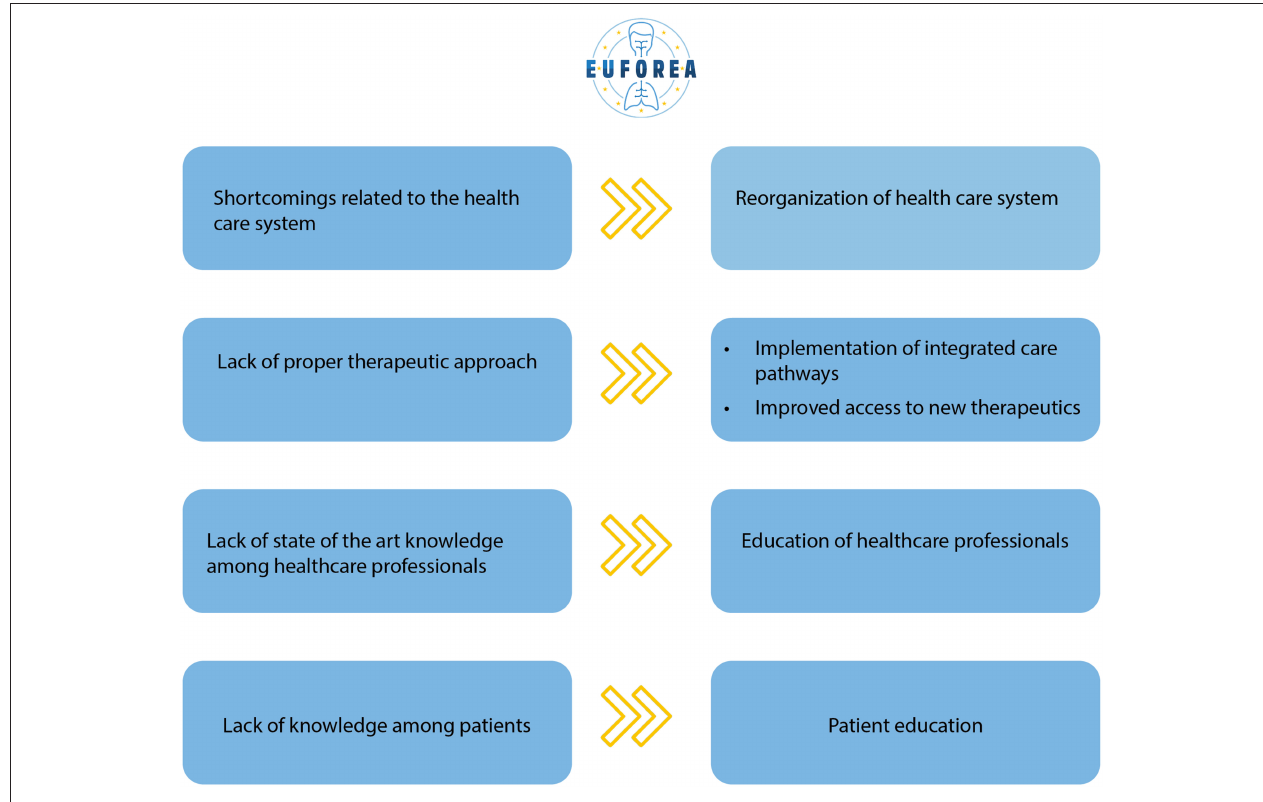
FIGURE 3 | Overview of the 4 key shortcomings and suggestions from patients with Type 2 inflammatory diseases.